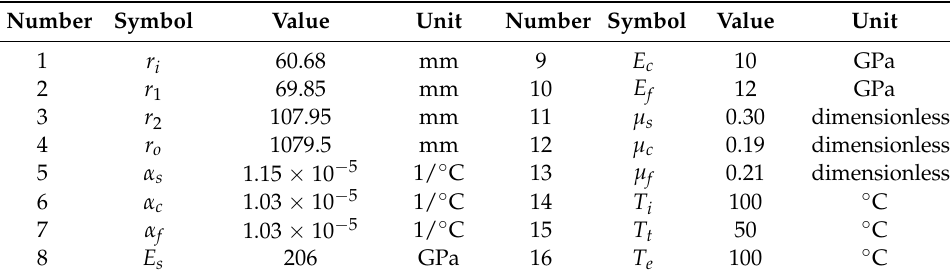
Table 1. Basic input